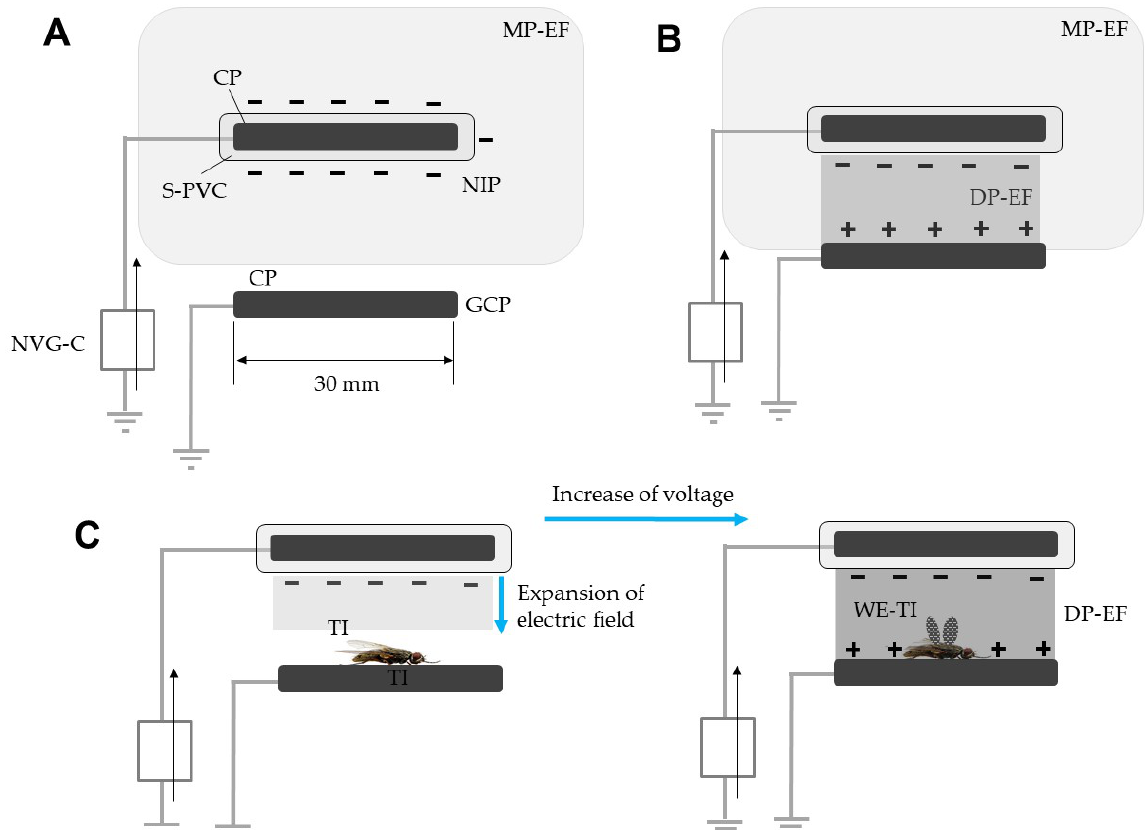
Figure 1. Structure of an experimental instrument for capturing insects and the formation of monopolar and dipolar electric fields. ( A ) Two identical conductor (iron) plates (CPs) were horizontally arranged; the upper plate was insulated with a soft polyvinyl chloride (S-PVC) resin and linked to a negative voltage generator (continuous-charge type) (NVG-C), and the lower plate was non-insu- lated and linked to a grounded line (cross-sectional view). A negatively charged insulated conduc- tor plate (NIP) formed a monopolar electric field (MP-EF) in the surrounding space. A grounded conductor plate (GCP) was located outside the MP-EF. ( B ) When the GCP entered the MP-EF, it was